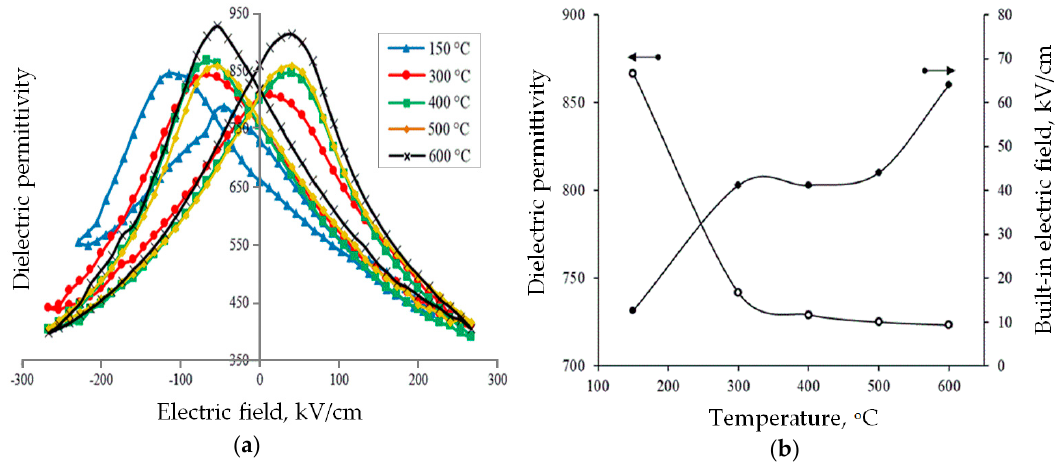
Figure 7. The dependences of parameters of Pt / PZT / Pt structure on the annealing temperature: ( a ) the dependence of the dielectric constant on external electric field; ( b ) the dependence of the dielectric constant and the internal electric field for the Pt / PZT / Pt structures on the annealing temperature. PZT films of 300 nm thickness were fabricated by magnetron sputtering of PZT target with 10 mol.% of PbO excess with following crystallization.